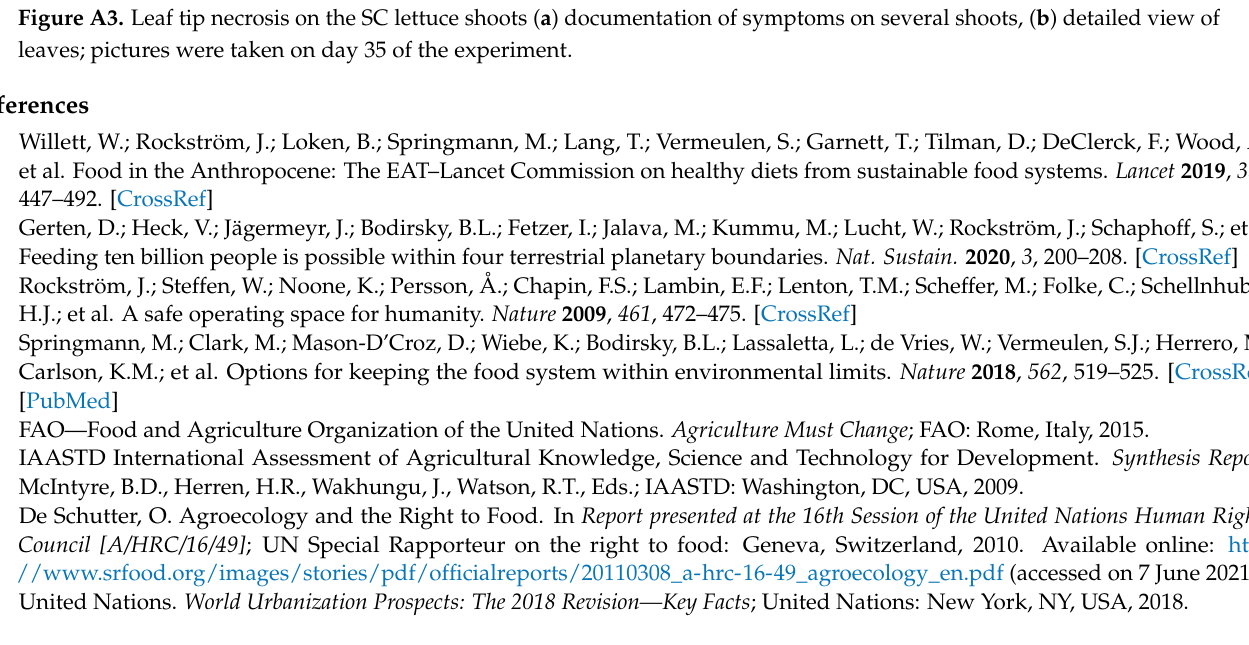
Figure A3. Leaf tip necrosis on the SC lettuce shoots ( a ) documentation of symptoms on several shoots, ( b ) detailed view of leaves; pictures were taken on day 35 of the experiment.